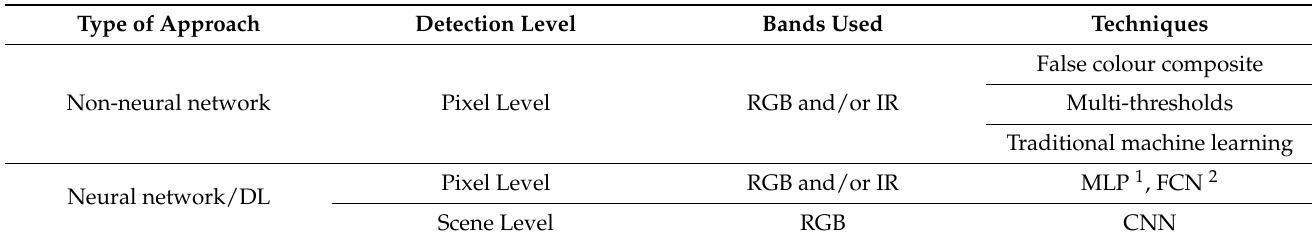
Table 1. Approaches used in satellite-based fire smoke